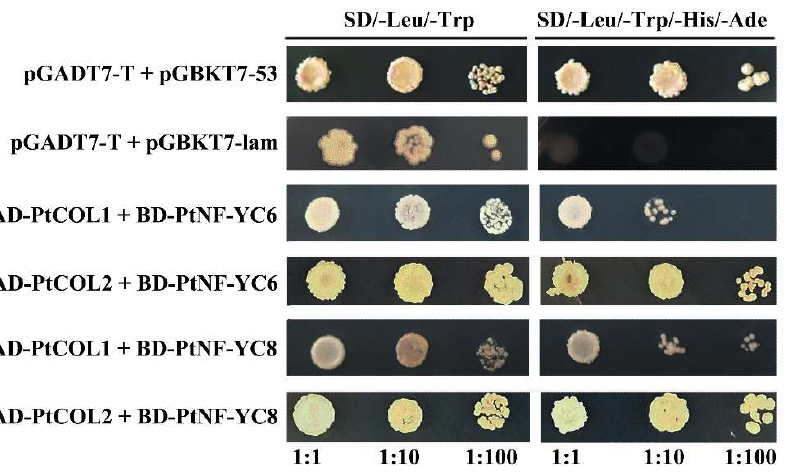
Figure 11. Y2H analysis of the interactions between PtoNF-YCs and PtoCOLs; 1:1, 1:10, and 1:100 represent the interaction of undiluted bacterial solution, 10-fold dilution and 100-fold dilution, re- spectively.